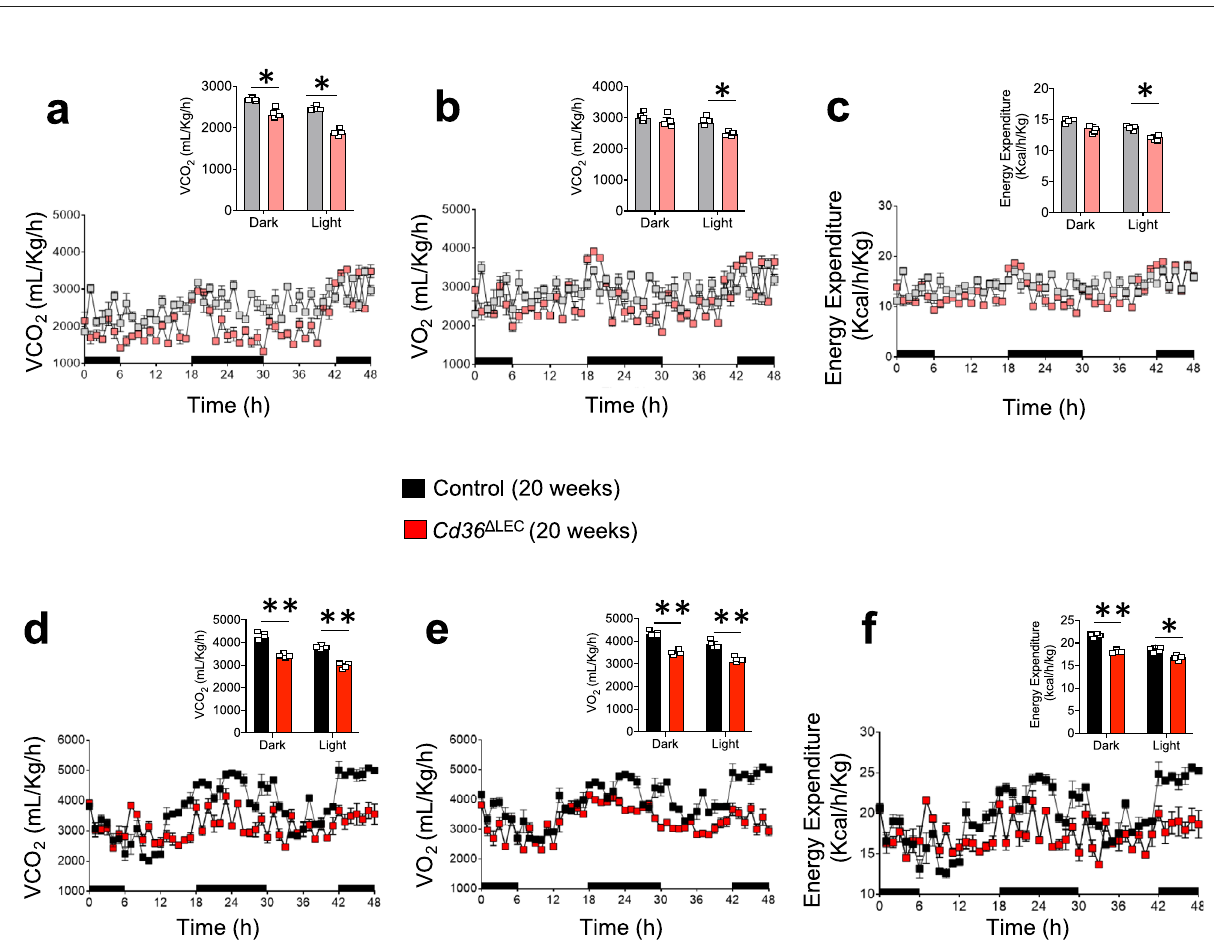
Fig. 4 Cd36 Δ LEC mice have reduced energy balance. Eleven- and 20-week-old Cd36 Δ LEC and control mice ( n = 4) were housed in metabolic cages for 48 h to monitor a , d carbon dioxide release rate (VCO 2 ), b , e O 2 consumption (VO 2 ), and c , f energy expenditure. Data are means ± SE with n representing the number of mice per group. Light grey: 11-week-old control mice; light red: 11-week old Cd36 Δ LEC mice. Statistical signi fi cance is determined by two-tailed Student t test. * P < 0.05; ** P < expected, no differences were observed in VE-cadherin junction integrity of lymphatic transport in control mice (Fig. 5c), BODIPY morphology for blood vessels surrounding the lacteals between leakage from lymphatic vessels in the mesentery was evident in the two mouse groups (Supplementary Fig. 4a). Cd36 Δ LEC mice (Fig. 5c). We next examined how lymph leakage in Collecting lymphatic vessels have continuous inter-endothelial Cd36 Δ LEC mice impacts lymph transport of absorbed lipid to the VE-cadherin junctions optimal for lymph transport 34 and circulation. The Cd36 Δ LEC and control mice received an disruption of vessel integrity can result in lymph leakage, as has intragastric bolus of olive oil after injection of Triton WR 1339 been reported in mice lacking one allele of Prox1 7 . We examined to inhibit lipoprotein lipase and rapid clearance of plasma lymph transport by lymphatic vessels in the mesentery collecting triglycerides (TGs) 31 . In control mice, plasma TG levels increased at 1 h (600 ± 90 mg/dl) following the oral fat bolus, peaked at 3 h vessels of Cd36 Δ LEC mice by fl uorescence microscopy after an intragastric load of the green fl uorescent long-chain fatty acid (846 ± 151 mg/dl), decreased at 5 h (452 ± 139 mg/dl) and tracer BODIPY C16 7 . While BODIPY highlighted lymph fl ow and returned back to pre-meal levels after 7 h (166 ± 28 mg/dl).